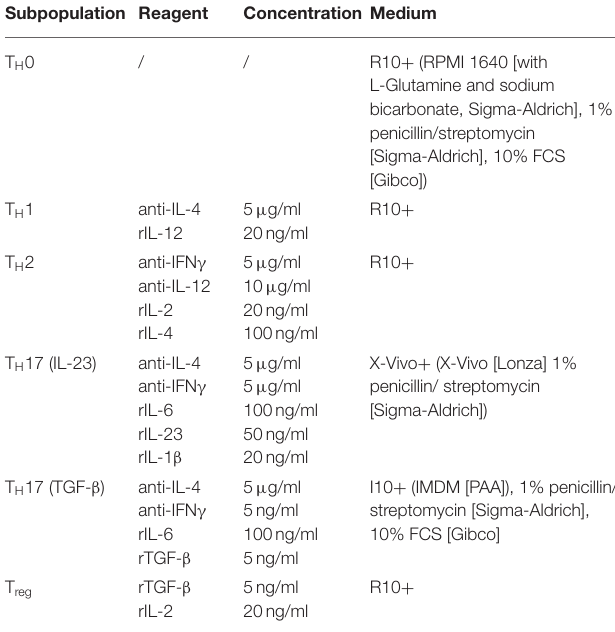
TABLE 1 | Stimulation media for T cell differentiation. Subpopulation